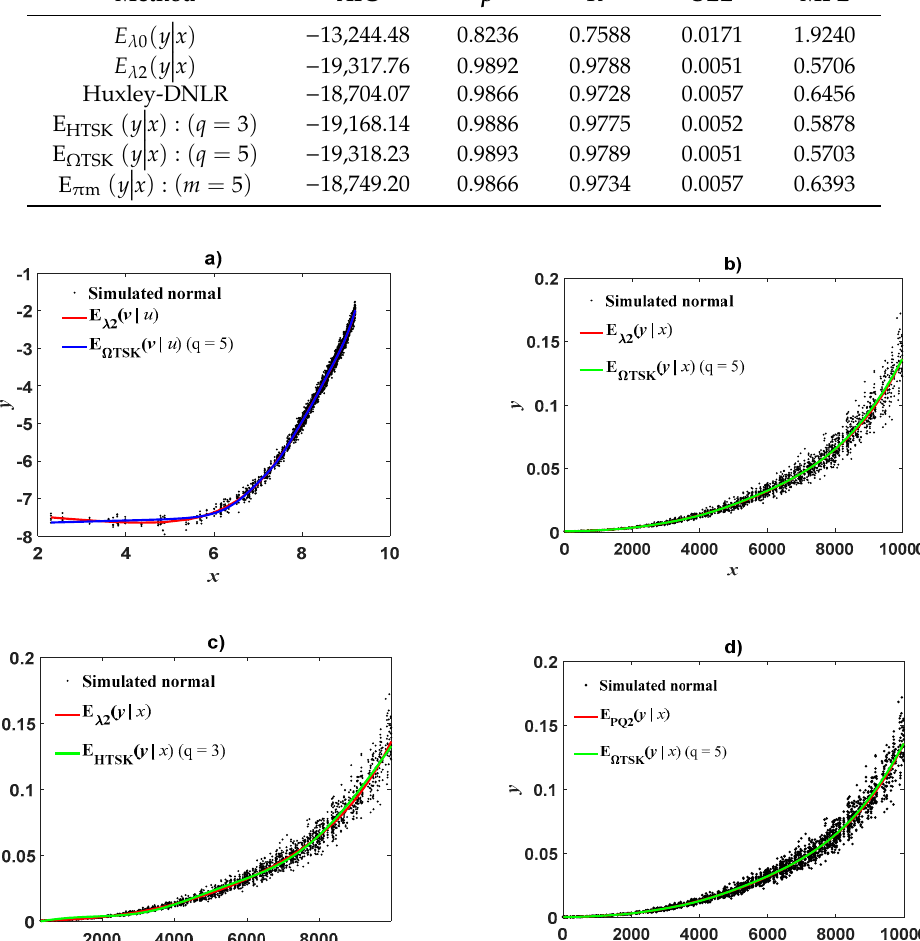
Figure 3. Comparison of λ 2 ( u ) and Ω TSK ( u ) fits on lognormally distributed data. Panel ( a ) comparison Figure 3. Comparison of 𝜆 (cid:2870) (𝑢) and Ω (cid:3021)(cid:3020)(cid:3012) (𝑢) fits on lognormally distributed data. Panel ( a ) of mean response functions fitted by means of a λ 2 ( u ) and a Ω TSK ( u ) proxies. Panel ( b ) compares comparison of mean response functions fitted by means of a 𝜆 (cid:2870) (𝑢) and a Ω (cid:3021)(cid:3020)(cid:3012) (𝑢) proxies. Panel ( b ) (cid:12) (cid:12) (cid:12) (cid:12) (cid:12) (cid:12) (cid:12) (cid:12) related retransformed forms E λ 2 ( y (cid:12) x ) and E Ω TSK ( y (cid:12) x ) . Panel ( c ) compares E λ 2 ( y (cid:12) x ) to E H TSK ( y (cid:12) x ) compares related retransformed forms 𝐸 (cid:3090)(cid:2870) (𝑦|𝑥) and 𝐸 (cid:2960)(cid:3021)(cid:3020)(cid:3012) (𝑦|𝑥). Panel ( c ) compares 𝐸 (cid:3090)(cid:2870) (𝑦|𝑥) to fitted by the regression model of Equation (33) in direct arithmetical scales. Panel ( d ) is a comparison 𝐸 (cid:2943)(cid:3021)(cid:3020)(cid:3012) (𝑦|𝑥) fitted by the regression model of Equation (33) in direct arithmetical scales. Panel ( d ) is a (cid:12) (cid:12) (cid:12) (cid:12) of E Ω TSK ( y (cid:12) x ) to E PQ 2 ( y (cid:12) x ) , the directly acquired projection function. This can be obtained by comparison of 𝐸 (cid:2960)(cid:3021)(cid:3020)(cid:3012) (𝑦|𝑥) to 𝐸 (cid:3017)(cid:3018)(cid:2870) (𝑦|𝑥) , the directly acquired projection function. This can be replacing the fitted parameter vector PQ into addressed MCA form in arithmetical space. We can be obtained by replacing the fitted parameter vector 𝑃𝑄 into addressed MCA form in arithmetical space. aware of reliable projections even without a CF.By acquiring non lognormally distributed replicates y k ( i ) ( ξ ) = β exp ( α lnx i + ξ k ) according to procedure of Equation (44), we examined error